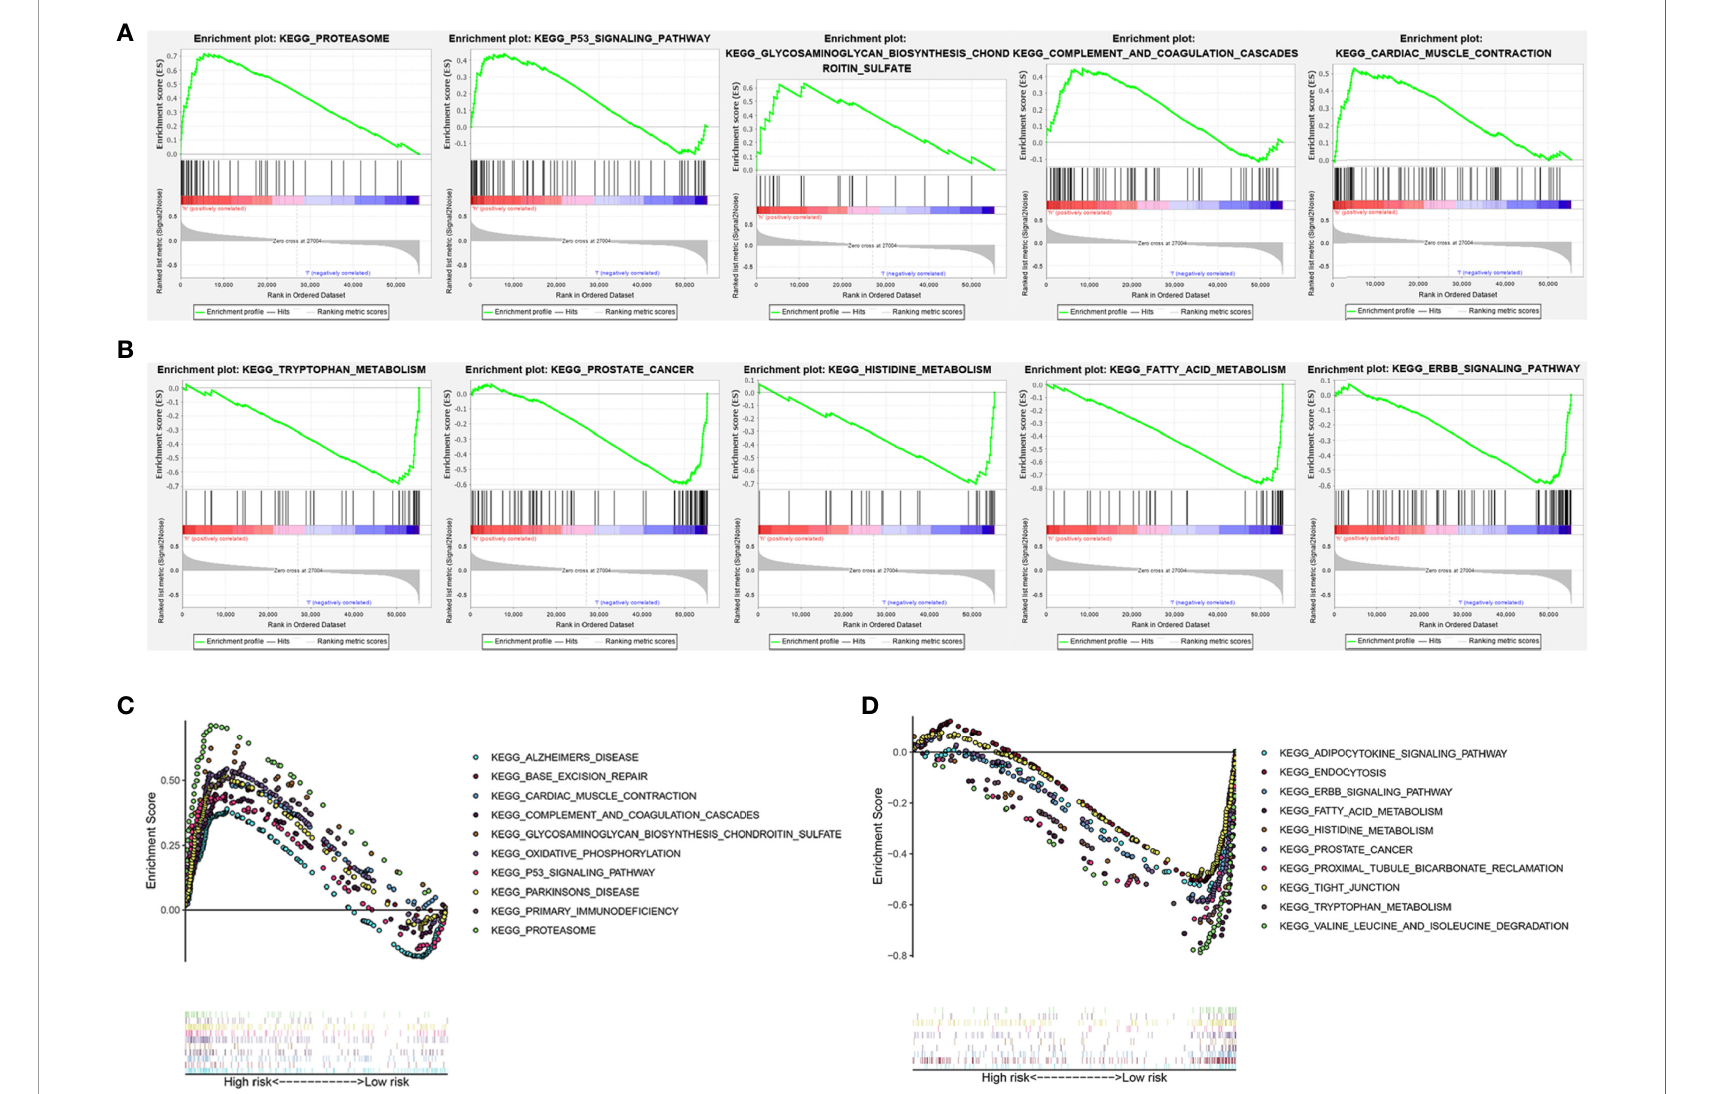
FIGURE 6 | Gene set enrichment analysis (GSEA) of the high- and low-risk subgroup in KIRC patients based on the prognostic signature. (A) GSEA showed that the top fi ve tumor hallmarks were enriched in the high-risk group. (B) GSEA showed that the top fi ve tumor hallmarks were enriched in the low-risk group. (C) The top 10 KEGG signaling pathways in high-risk KIRC patients. (D) The top 10 KEGG signaling pathways in low-risk KIRC